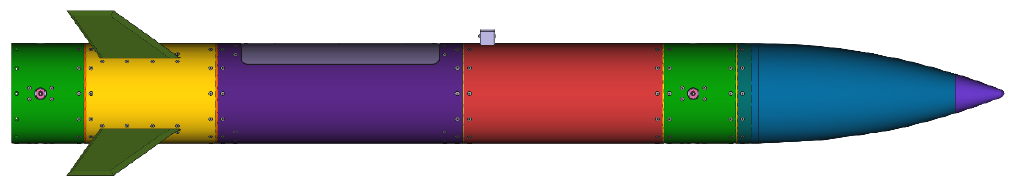
Figure 2. The 152.4 mm generic projectile.